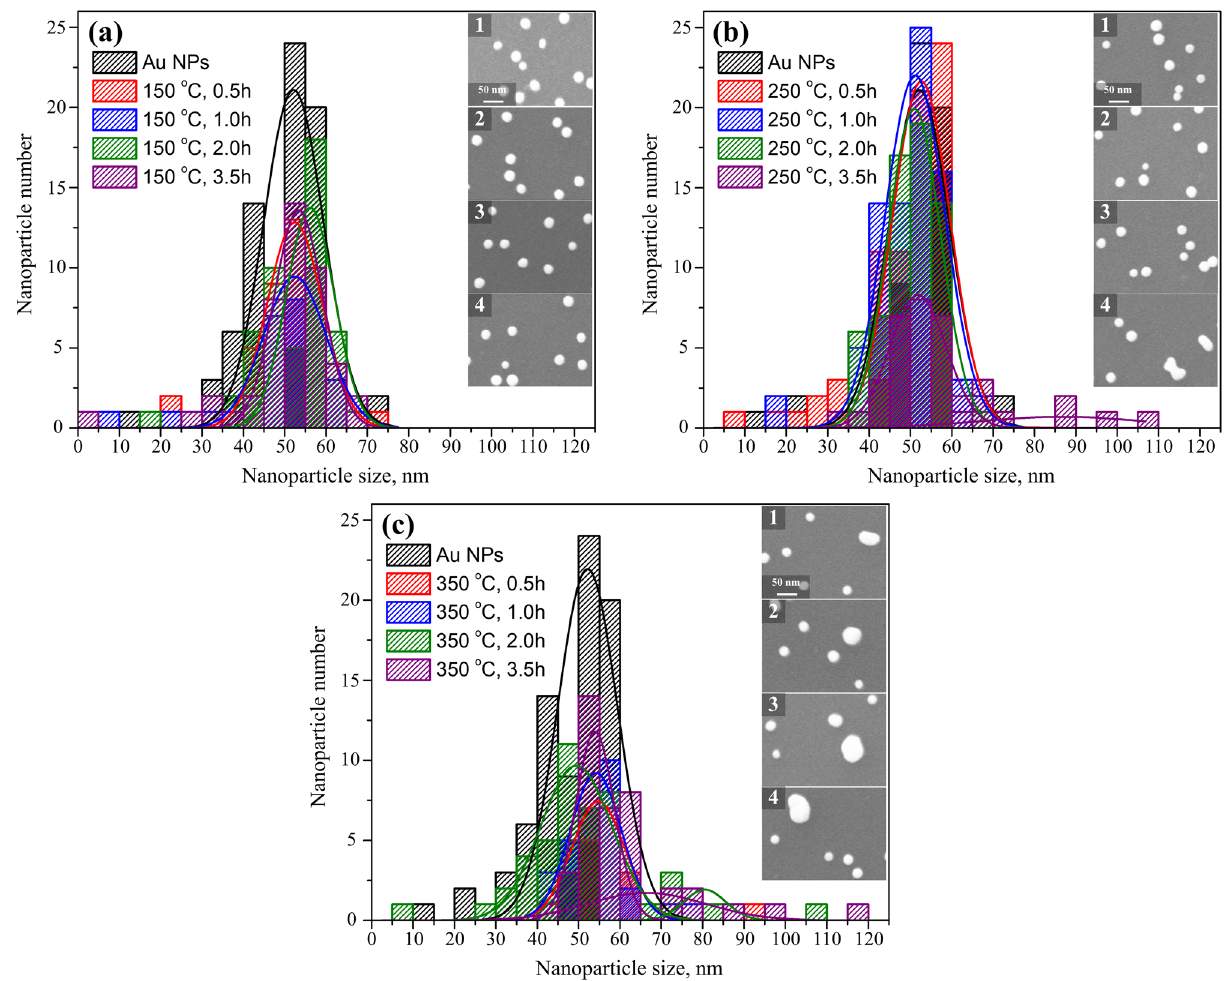
Figure 3. Histograms of particle size distributions for the initial Au NPs and the treated Au NPs after thermal treatment at ( a ) 150, ( b ) 250 and ( c ) 350 °C for varying time period. Lines represent Gaussian fittings of the distributions. The insets are the SEM micrographs of Au NPs on SiO 2 after each temperature treatment for 0.5, 1, 2, 3.5 h (From top to bottom).